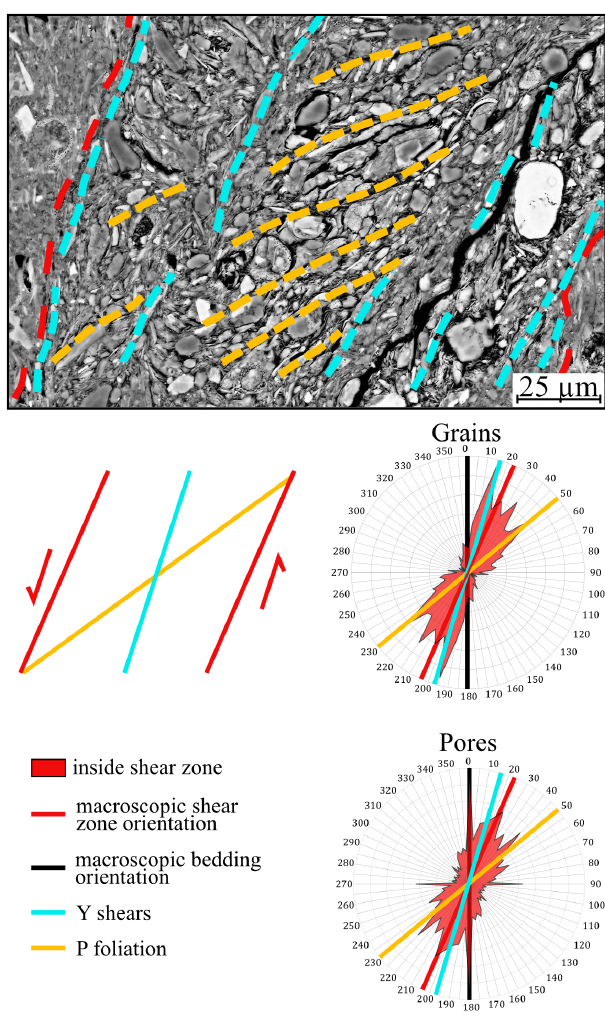
Figure 10. Structures mapped in the shear zone (zoom-in from Fig. 9). Grain and pore orientation indicate the development of Y shears and P foliation, which are both represented by orientation peaks of grains.